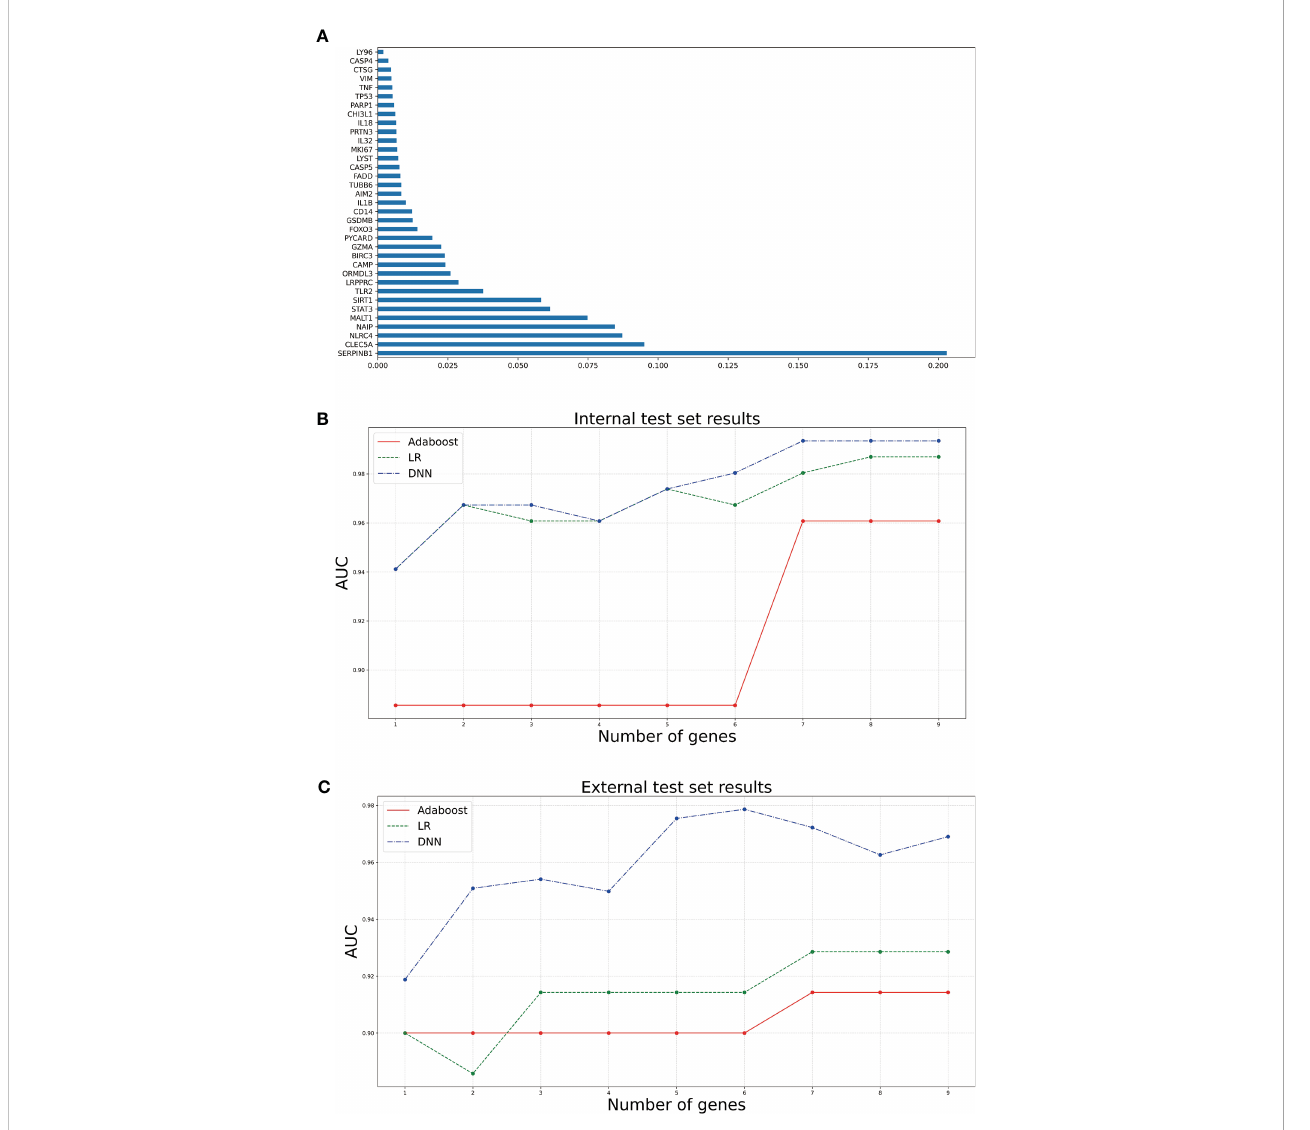
FIGURE 3 Bar and line graphs associated with diagnostic model construction. (A) is a bar graph of the 35 genes ranked by feature importance using RF algorithm. (B, C) are line plots of the AUCs corresponding to different numbers of top genes selected using the three classi fi ers on the internal and external test sets, respectively.